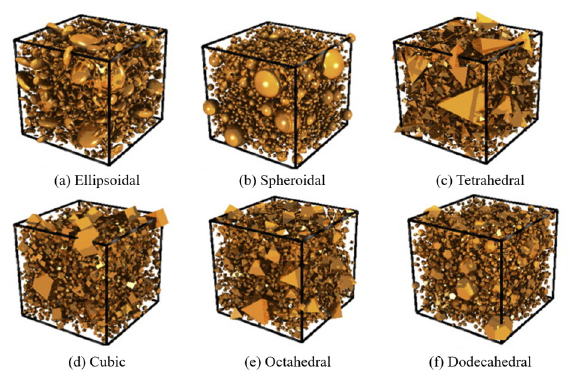
Figure 1. Schematic diagram of the multi ‐ phase representation of concrete heterogeneity and random generation and packaging of coarse aggregates. Adapted from [27].